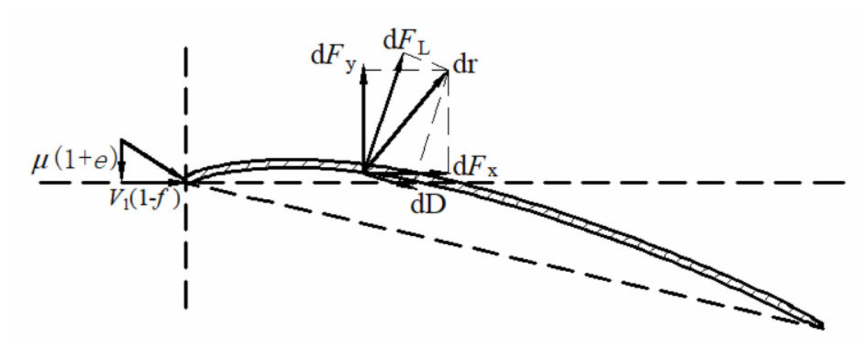
Figure 9. Differential pressure lift